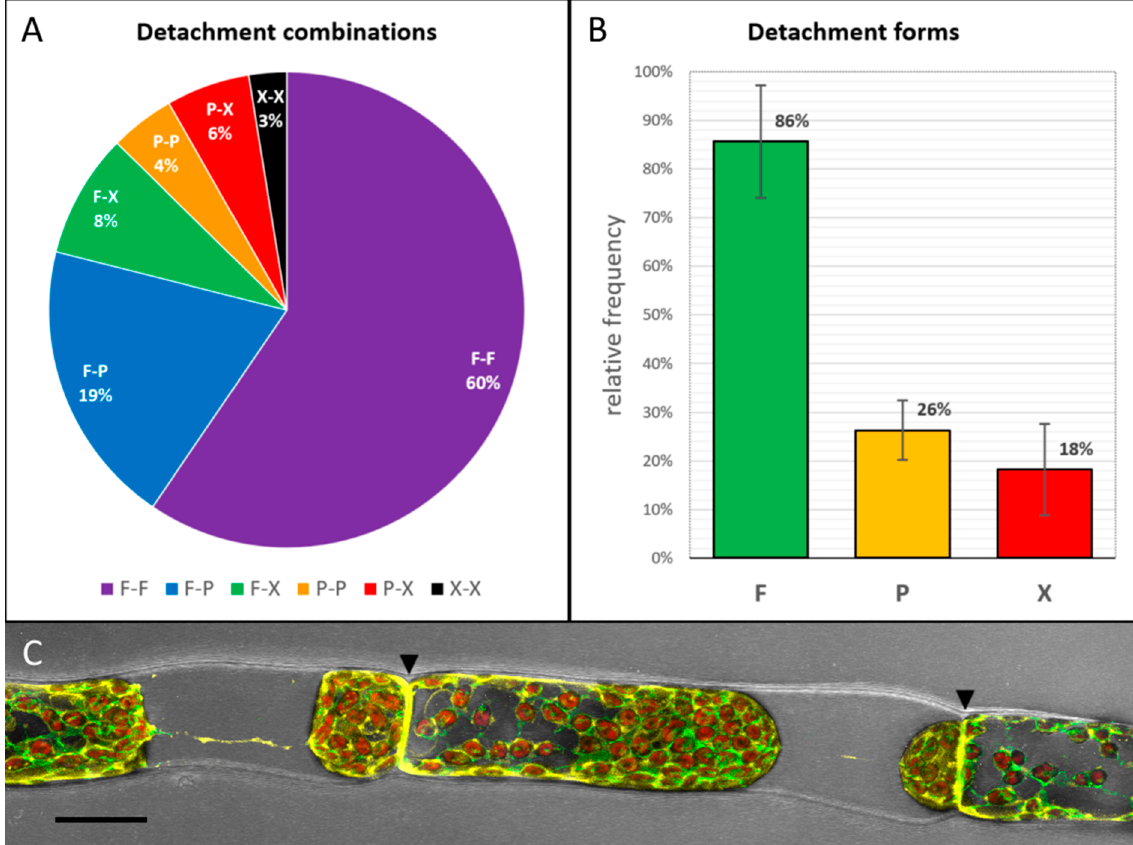
Figure 2. Detachment forms of protoplasts of two connected cells from their adjoining cell wall. F: fully attached, P: partially detached, X: fully detached. n = 603. ( A ) Detachment combinations: In 60% of the investigated cell pairs, both protoplasts remained attached at the connecting cell wall after plasmolysis. ( B ) Of plasmolyzed protoplasts 86% stayed fully attached to the adjoining cell wall, 26% remained partially attached and only 18% of cells showed full detachment. ( C ) A filamentous P. patens cells after plasmolysis: the protoplasts stay fully attached at both sides of the adjacent walls (arrowheads; F-F type) but are detached at the longitudinal walls. Overlay of transmission channel (grey) and fluorescence of endoplasmatic reticulum (ER; green), chloroplasts (red) and plasma membrane (PM) (yellow). Scale bar = 20 µm.